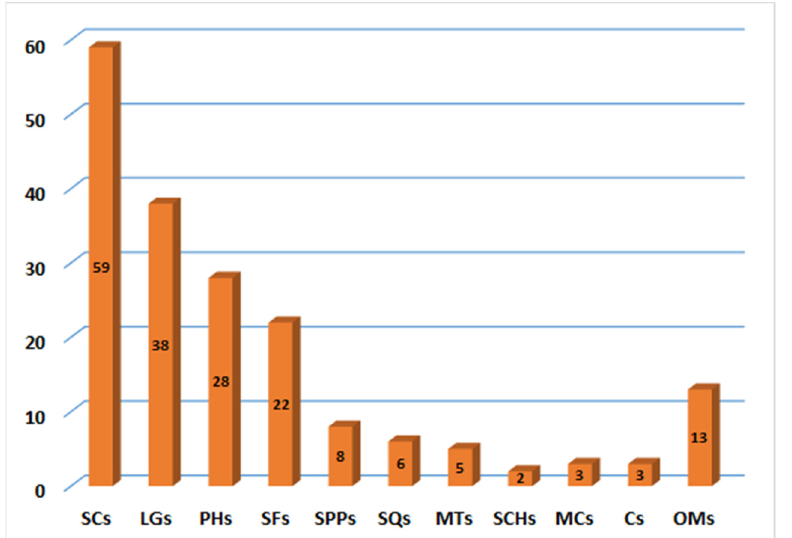
Figure 22. Number of compounds reported from various classes of F. sinkiangensis . SCs: Sesquiterpene coumarins; LGs: Lignans; PHs: Phenolics; SFs: Sulfanes; SPPs: Sesquiterpene phenylpropanoids; SQs: Sesquiterpenes; MTs: monoterpenes; SCHs: Sesquiterpene chromones; MCs: Monoterpene coumarins; Cs: coumarins; OMs: Other metabolites.